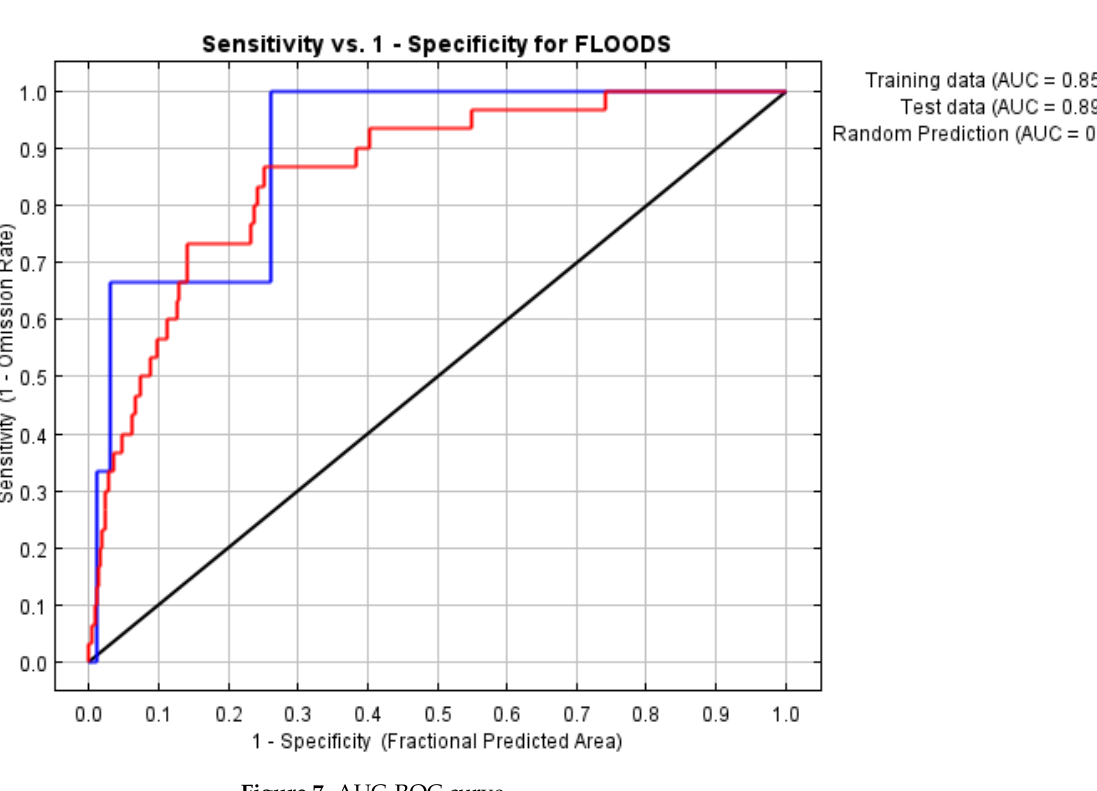
Figure 7. AUC-ROC curve.